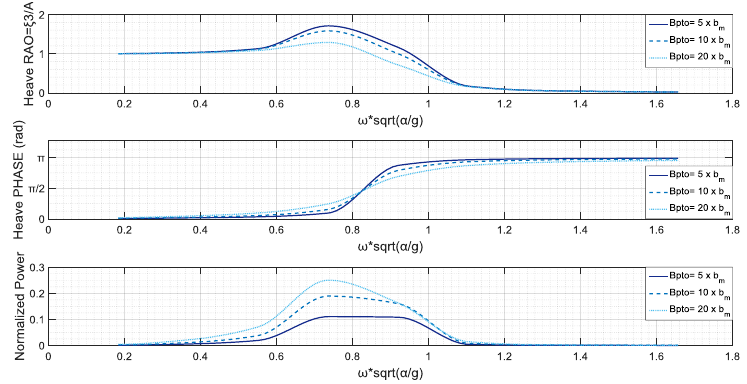
Figure 11. Heave RAO, Phase RAO and Normalized Power Output-Floater-shaped WEC.